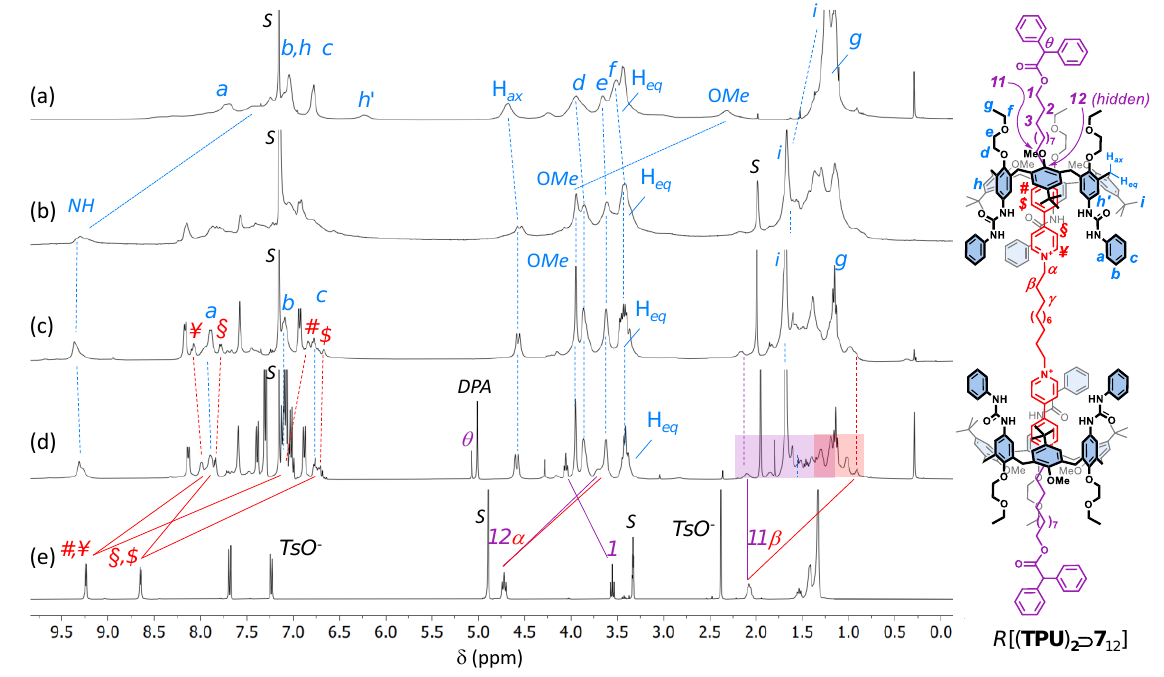
Figure 2. 1 H NMR stack plot (400 MHz, C 6 D 6 ) of ( a ) TPU ; ( b ) mixture of 5 6 with TPU (2 eq.); ( c ) [3]pseudorotaxane P [( TPU ) 2 ⊃ 5 12 ]; ( d ) [3]rotaxane R [( TPU ) 2 ⊃ 7 12 ] (the purple and orange boxes highlight the upfield-shifted resonances of the external and internal alkyl chains of the complexed dumbbell 7 12 , while the resonance with the DPA label shows the methine proton of the diphenylacetate anions that have exchanged the tosylates upon axle stoppering); and ( e ) 5 12 (taken in CD 3 OD for solubility reasons). For the protons’ labels, see the sketch on the right (the tosylates have been omitted for more clarity).